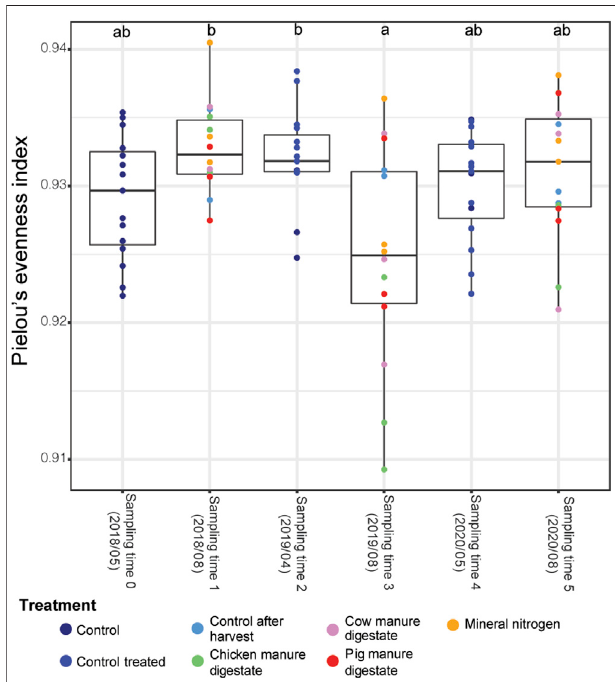
FIGURE 1 | Pielou ’ s evenness index. On the X -axis are indicated samplingtimes,dotsaredifferentlycoloredwithrespecttotreatments:control (beforefertilization,nofertilization),control-treated(beforefertilization,fertilized the precedent year), control after harvest (after harvest, no fertilization), mineral nitrogen (after harvest), chicken manure digestate (after harvest), cow manure digestate (after harvest), and pig manure digestate (after harvest).